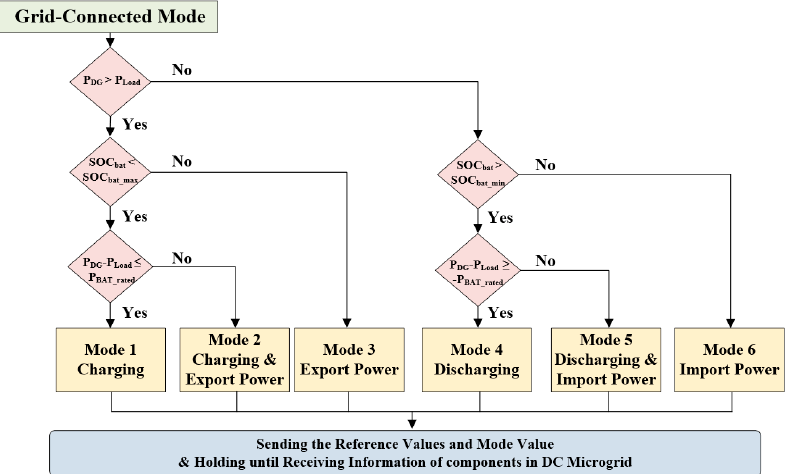
Figure 5. Flowchart of proposed EMS for operation method in grid-connected mode.